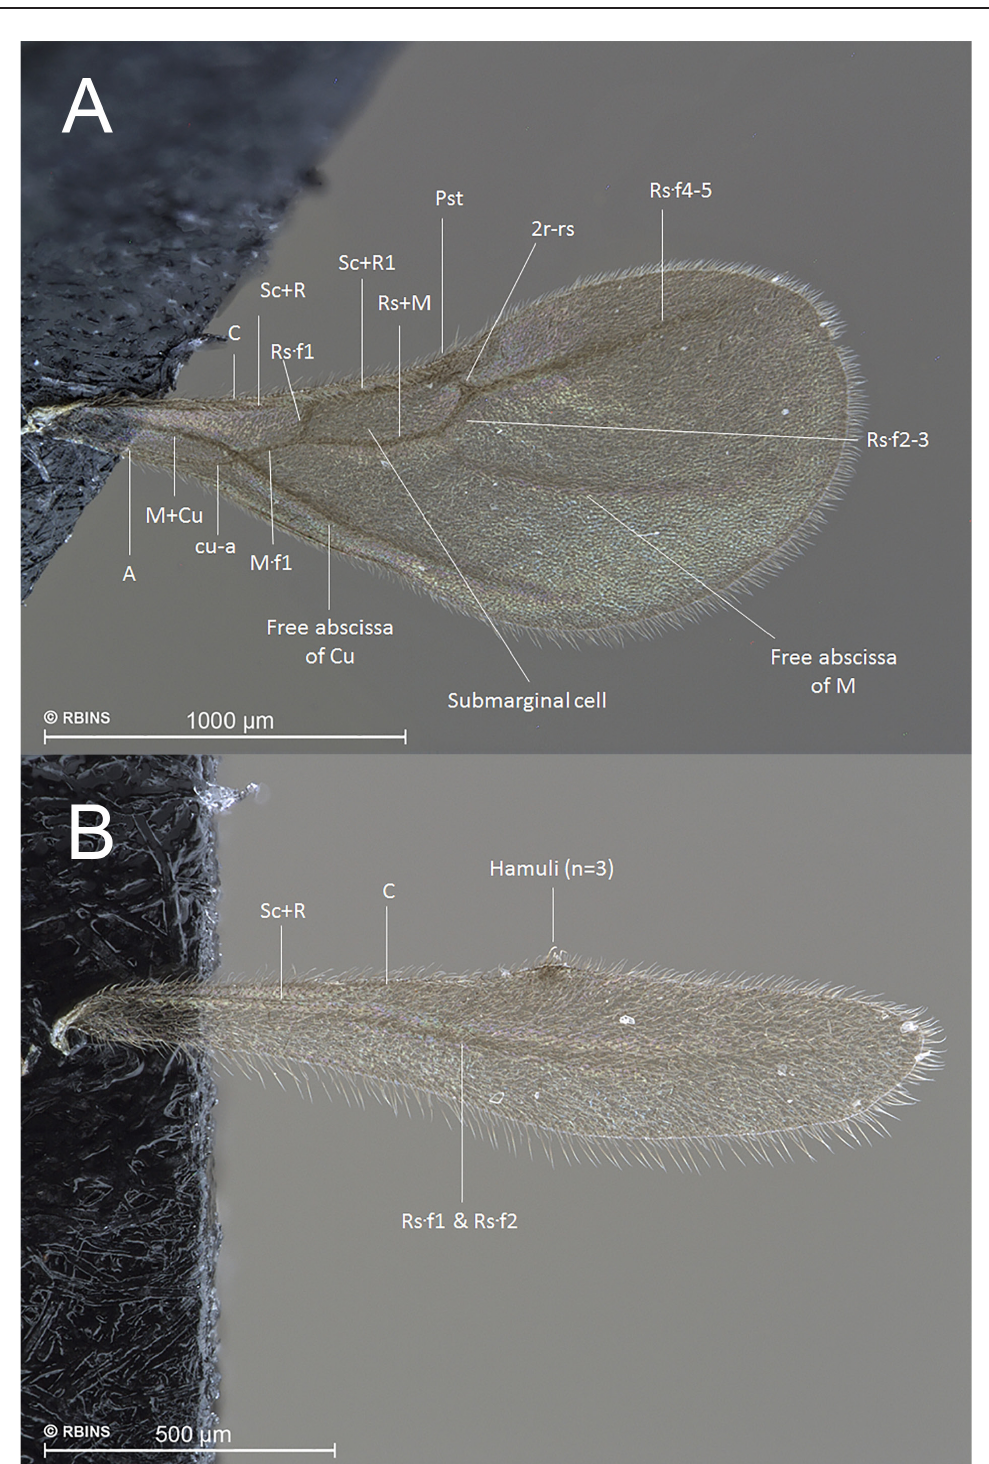
Fig. 9. Wings of Leptanilloides ‘Male 4’ (specimen code 4870101) and terminology used in the description. A . Forewing. B . Hindwing. Abbreviations: 2r-rs = second radial-radial sector crossvein, A = anal vein, C = costal vein, Cu = cubital vein, cu-a = cubital-anal crossvein, M = medial vein, M·f1 = first free abscissa of medial vein, M+Cu = fused medial-cubital veins, Pst = pterostigma, Rs+M = fused medial and radial sector veins, Rs = radial sector, Rs·f1 (to Rs·f5) = first (to fifth) free abscissa of radial sector vein, Sc+R = fused subcostal and radial veins, Sc+R1: fused subcostal and first radial